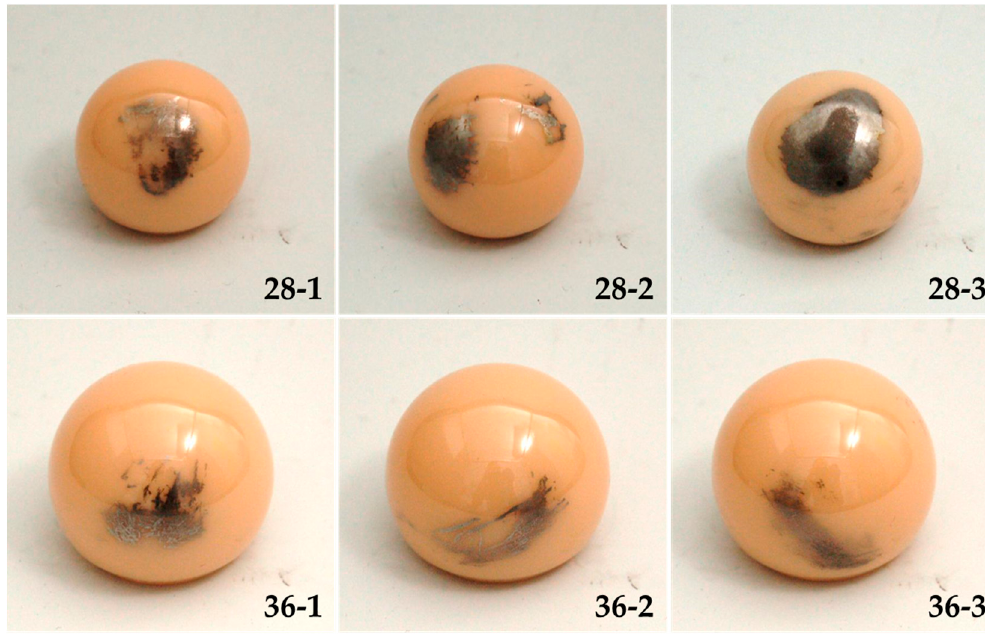
Figure 1. Retrieved femoral heads made of alumina (Al 2 O 3 ) with metallic transfer, 28 mm ( n = 3) and 36 mm ( n = 3) in diameter.